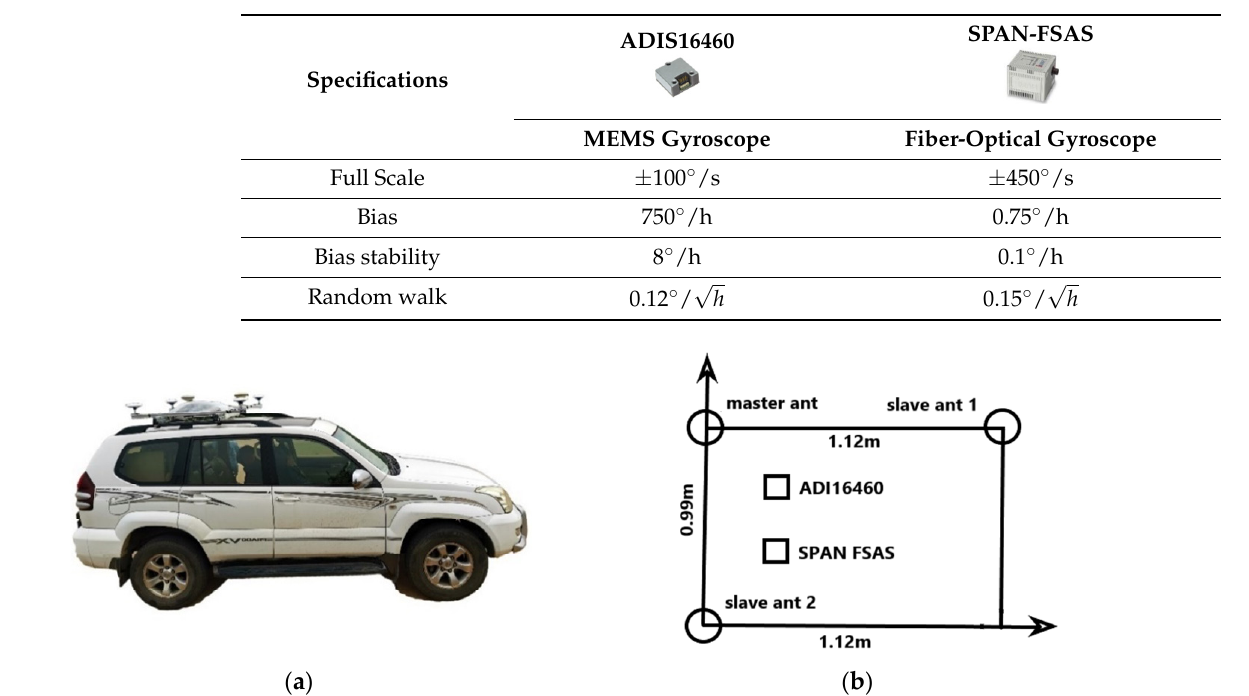
Table 1. Specifications of the gyroscopes in the AIDS16460 and the SPAN-FSAS.